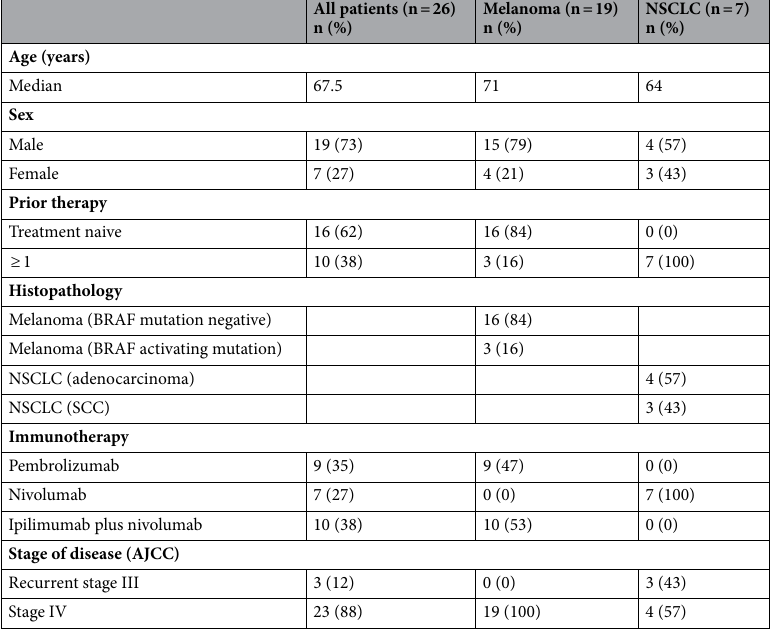
Table 1. Patient